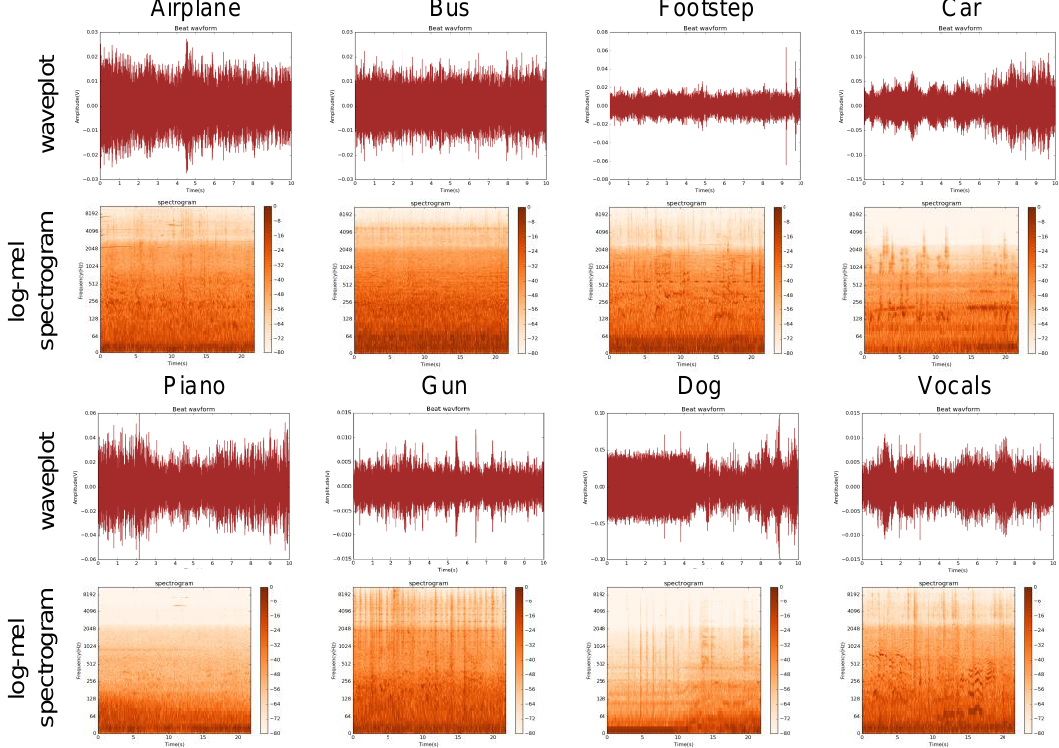
Figure 11. Wave plot and log-scaled Mel-spectrogram of eight different sound source scenes. It can be clearly seen that there are obvious differences between the sound fragments of different types of sound sources.